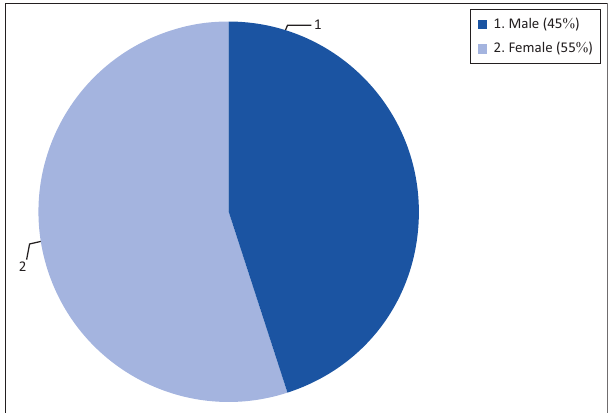
FIGURE 1: User gender.